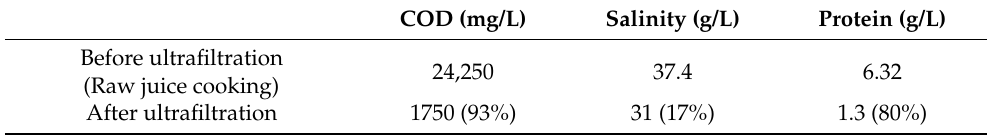
Table 5. Characterization of tuna cooking juice before and after ultrafiltration process.